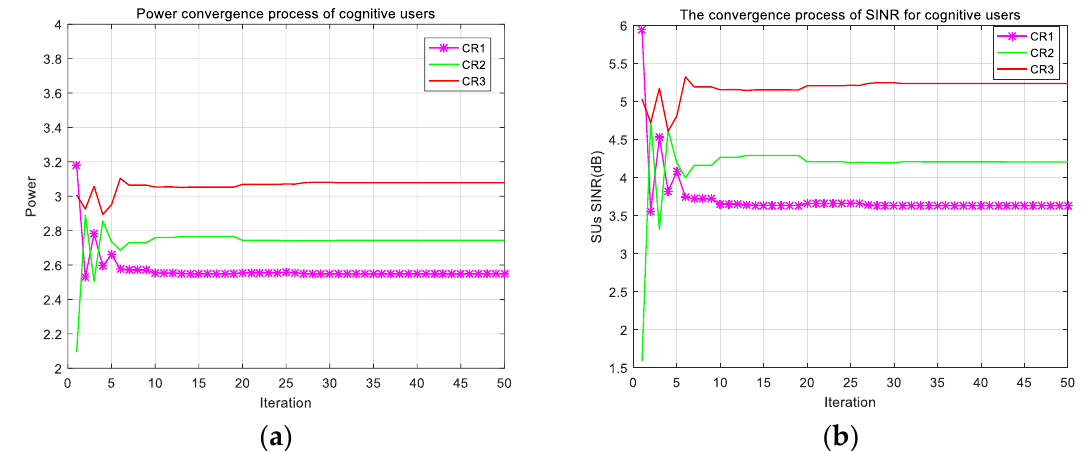
Figure 6. ( a ) Power convergence process of SUs; ( b ) SINR convergence process of cognitive users.